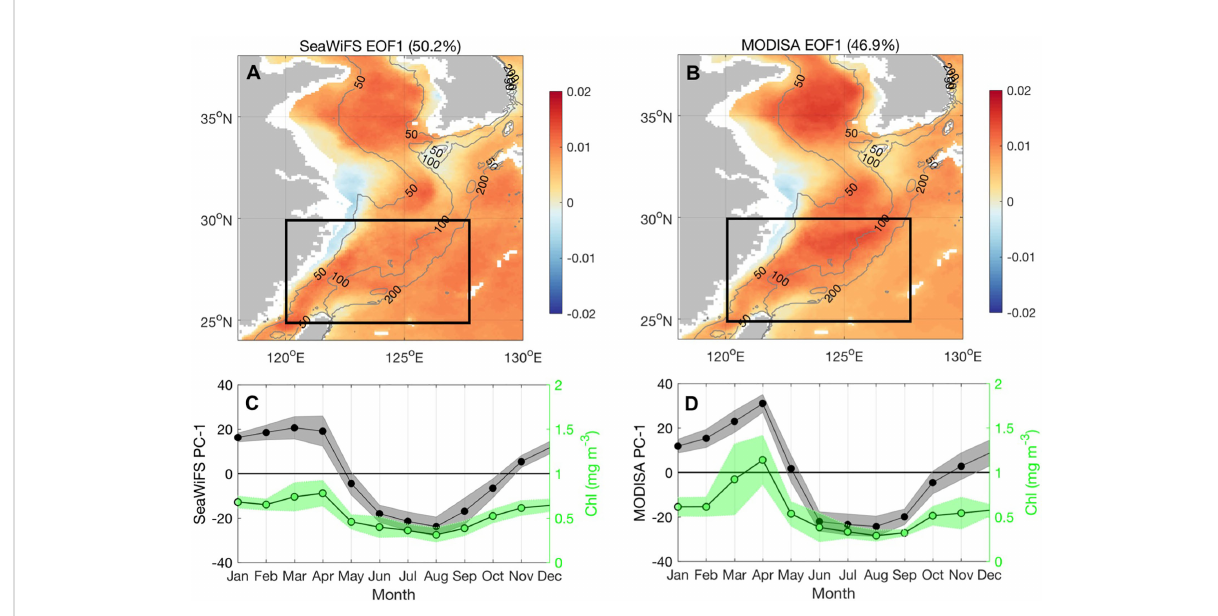
FIGURE 2 The EOF fi rst mode of SeaWiFS and MODISA Chl -a . (A, B) The fi rst EOF mode spatial coef fi cient of SeaWiFS and MODISA Chl -a , respectively; the gray contour lines denote the 50-, 100-, and 200-m isobaths. (C, D) The monthly averaged EOF PC-1 with standard deviations for SeaWiFS and MODISA Chl -a . The green shading in (C, D) denote the monthly climatology and standard deviations of spatial mean Chl -a in the box (25° – 30° N, 120° – 128°E) with water depth between 50 m and 200 m for SeaWiFS and MODISA periods,